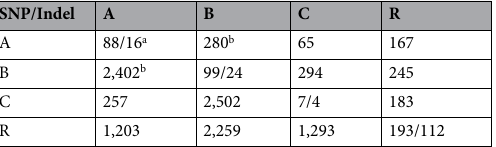
Table 2. Summary of inter-species and intra-species variations based on chloroplast genomes. a 18/16 denotes the number of SNP/Indel variations in the A genome. b B genome has 2,402 and 280 SNP and InDel variations, respectively, compared with the A